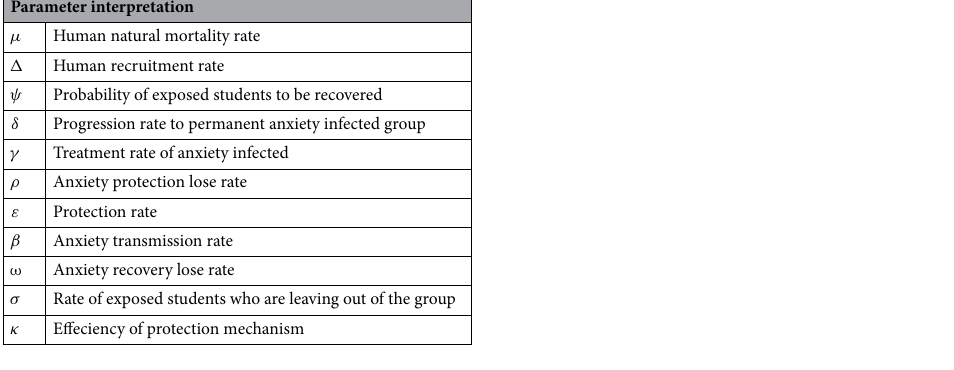
Table 1. Interpretation of the model parameters.